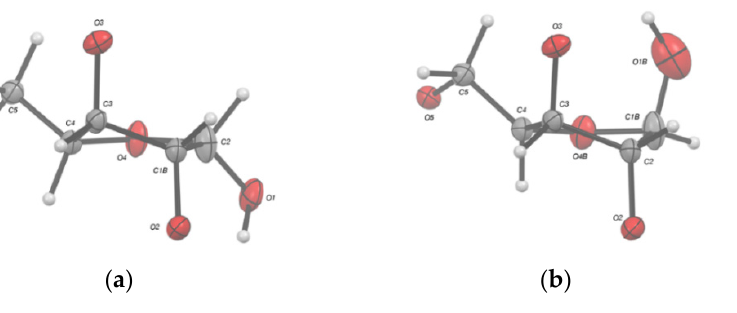
Figure 2. Close-up of the sugar ring puckering C3-endo, C2-exo (N-type) conformations for the ( a ) α form, and ( b ) β form. ( c ) Conformation of the 2,3,5- tri-O -benzyl- β - D -arabinofuranose analogue, depicted in the CCDC Refcode: LUHROX.